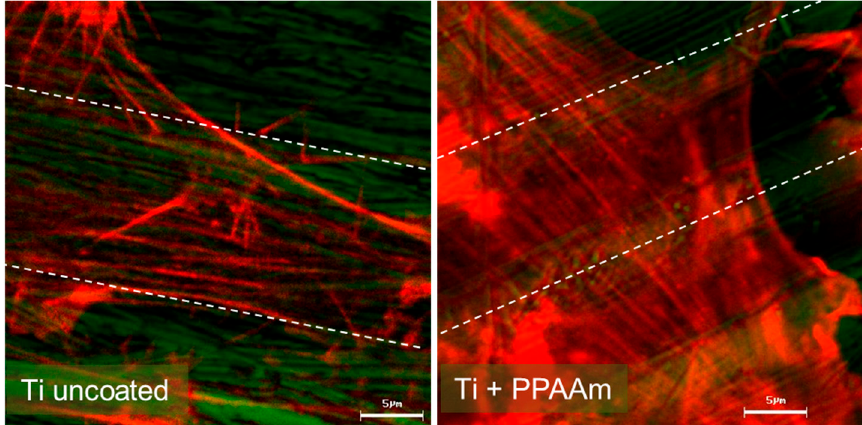
Figure 1. Cell alignment on stochastically structured Ti surfaces (Ti cp, grade 2, Ra 0.315 µm, [15]). Left: The actin filaments are aligned in the direction of the striations (dashed lines in grey) caused by machining. Right: Abrogated alignment due to PPAAm nanolayer coating of Ti (960 s gross) [15]. Technical description: Confocal laser scanning microscopy (LSM 410, Carl Zeiss AG, Oberkochen, Germany), scale bar 5 µm, actin staining (red) with Alexa Fluor 546 phalloidin, Ti surface in reflection mode false colored in green.